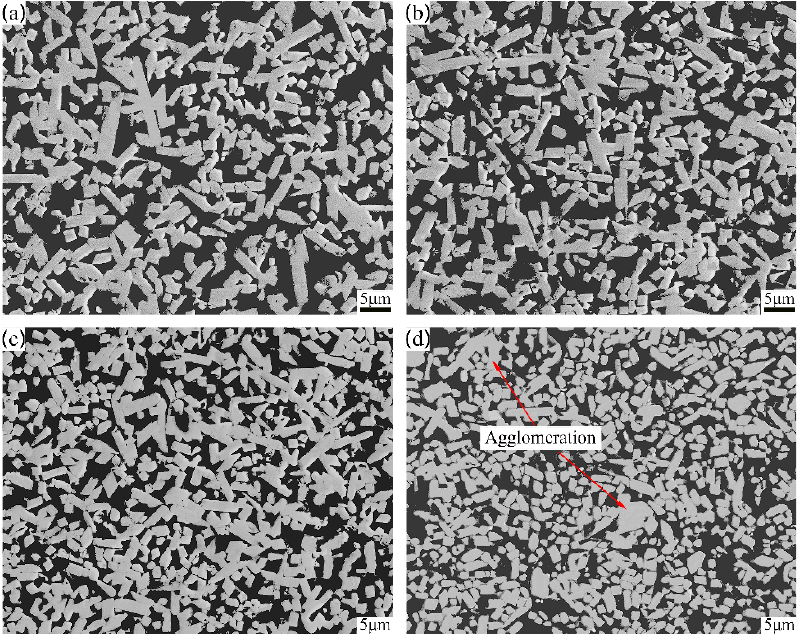
Figure 4. Microstructure of Mo 2 FeB 2 based cermets with different Mo contents: ( a ) 43.5 wt.%; ( b ) 45.5 wt.%; ( c ) 47.5 wt.%; ( d ) 49.5 wt.%.